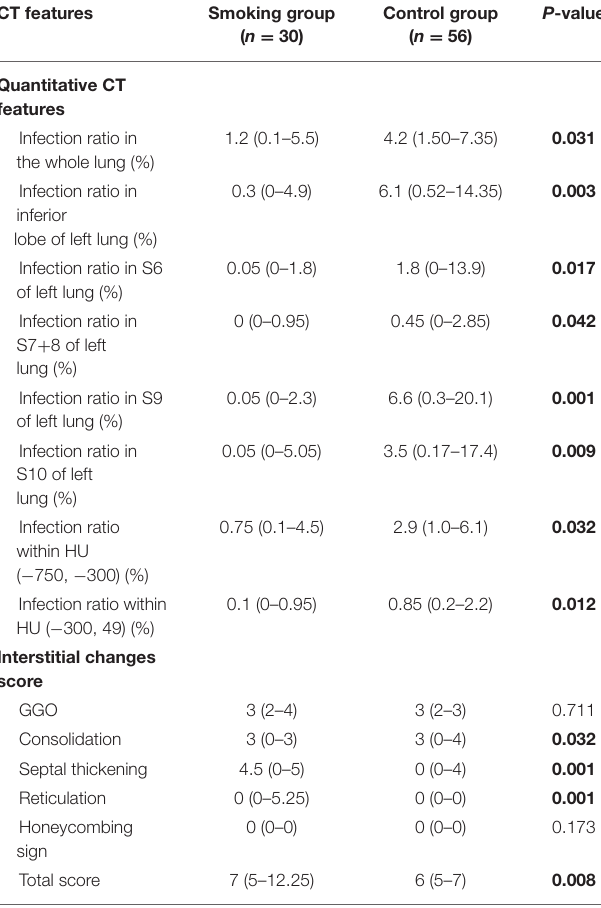
TABLE 1 | Demographic and clinical